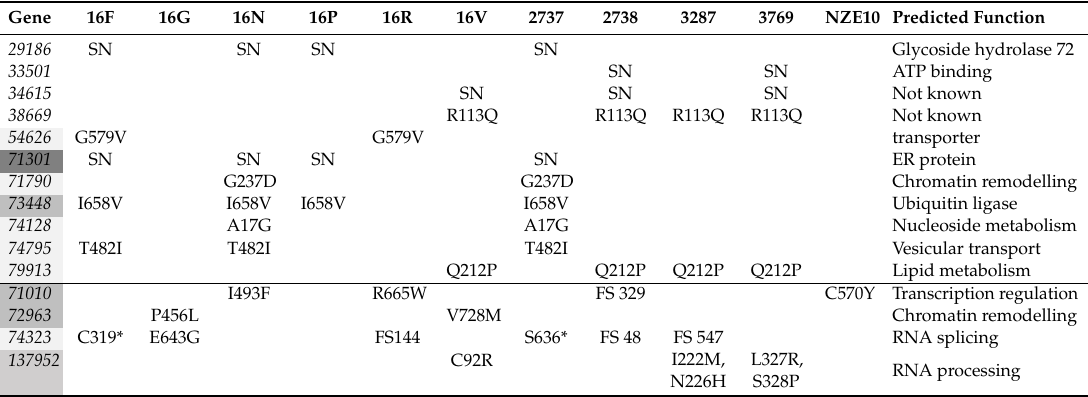
Table 3. Genes with single nucleotide polymorphisms (SNPs) in more than one